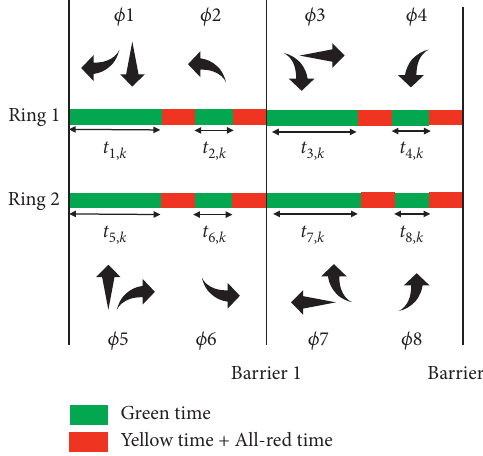
Figure 2: Standard ring-and-barrier signal logic.